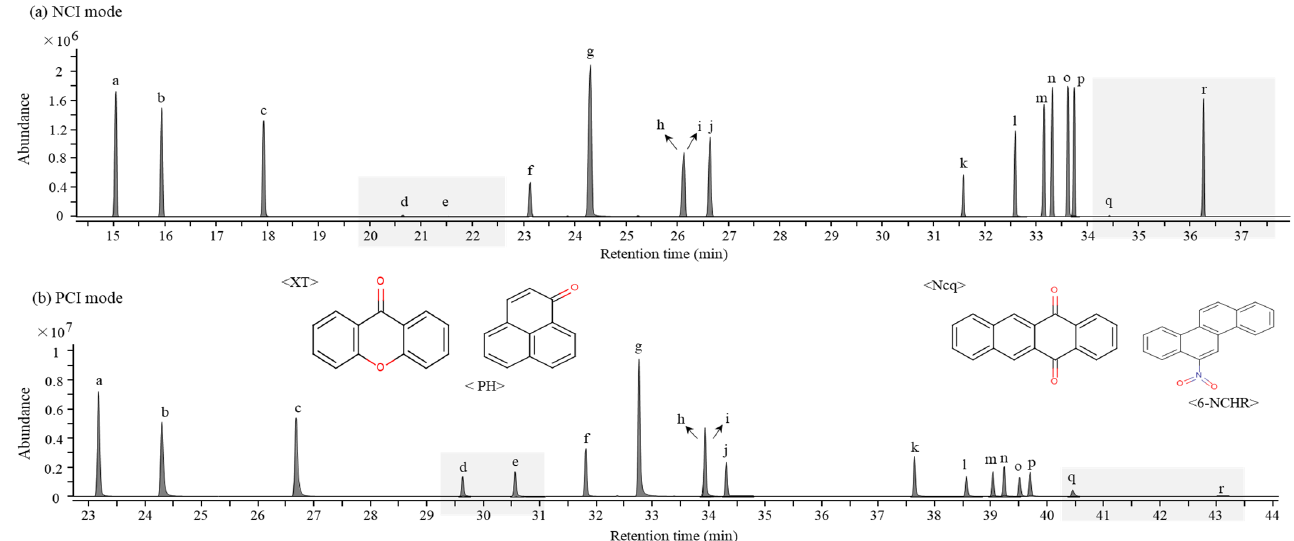
Figure 2. Comparison between SIM and SRM modes of a standard solution with NPAHs and OPAHs (4 μ g/ m L): ( a ) SIM chromatogram under NCI condition on DB-5MS UI capillary column (30 m × 0.25 mm × 0.25 μ m); ( b ) SRM chromatogram under PCI condition on DB-5MS UI capillary col- umn (60 m × 0.25 mm × 0.25 μ m). The gray shading indicates four congeners, with a significant difference in sensitivity between the two detection methods. The peak identities were as follows: